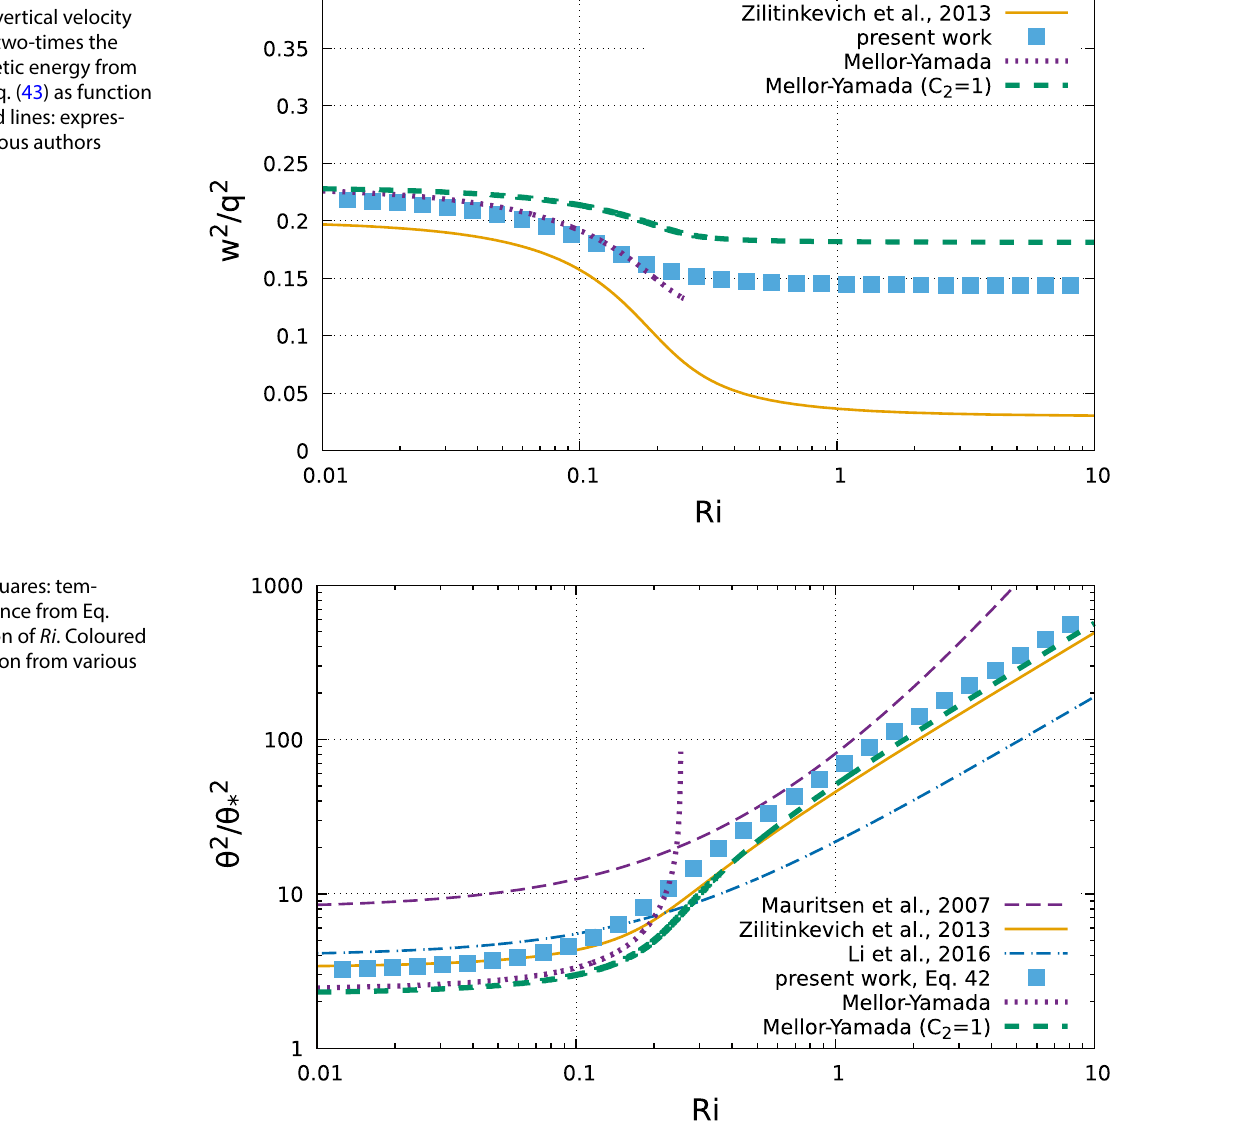
Fig. 5 Blue squares: ratio between the vertical velocity variance and two-times the turbulent kinetic energy from Eq. (40) and Eq. (43) as function of Ri . Coloured lines: expres-